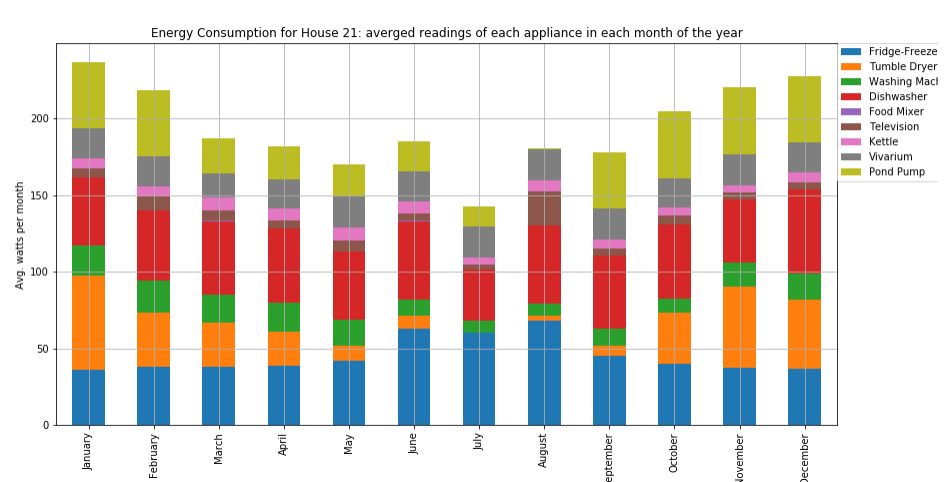
Figure A8. The average consumption per month of home appliances for house 21 with four occupants.